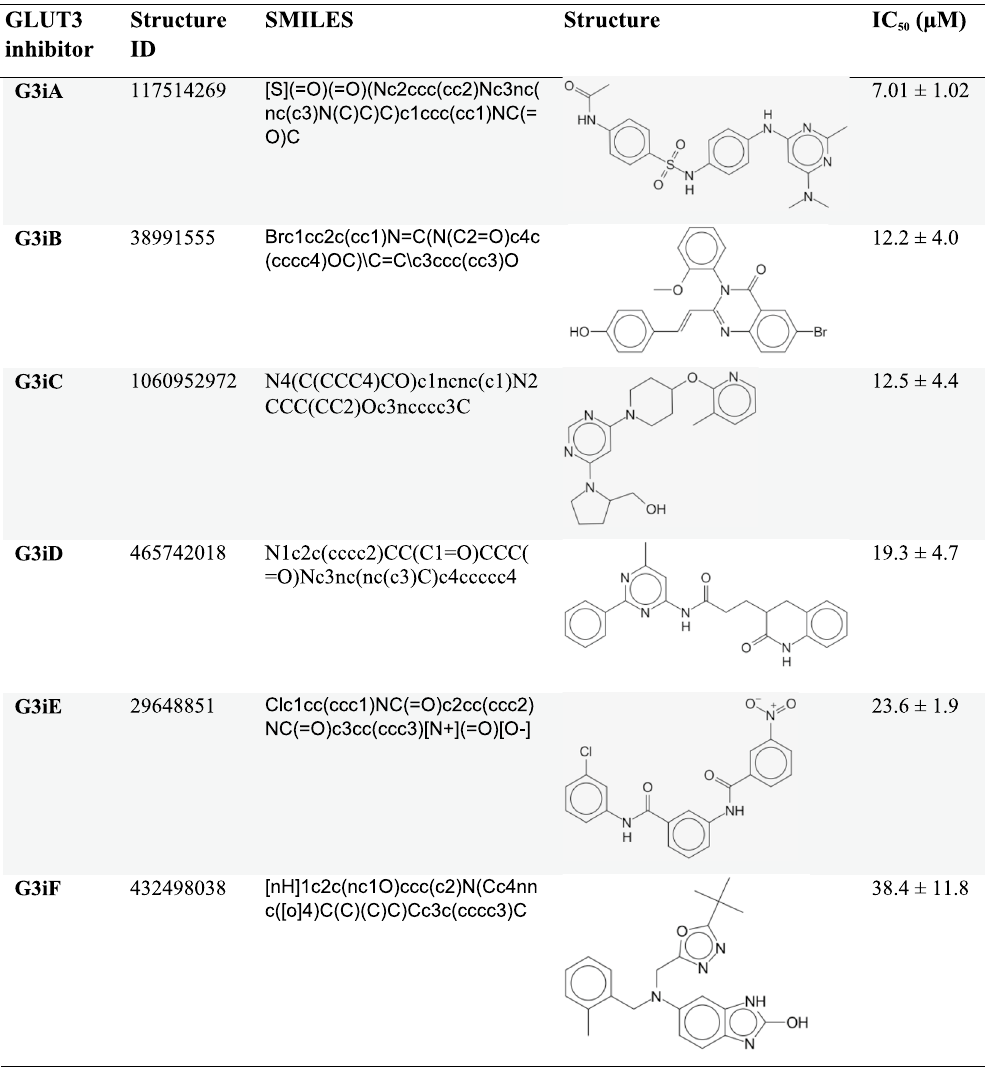
Table 1. Structures of GLUT3 inhibitors. For each GLUT3 inhibitor, the ChemNavigator structural ID, SMILES code, and IC 50 values for GLUT3 inhibition are indicated. Corresponding dose–response curves are in Fig. 2B– G. G3iA, G3iB, and G3iD are inhibitors resulted from TBVS of the outward-facing GLUT3 conformation; G3iC, G3iE, and G3iF are inhibitors produced by TBVS of the inward-facing GLUT3